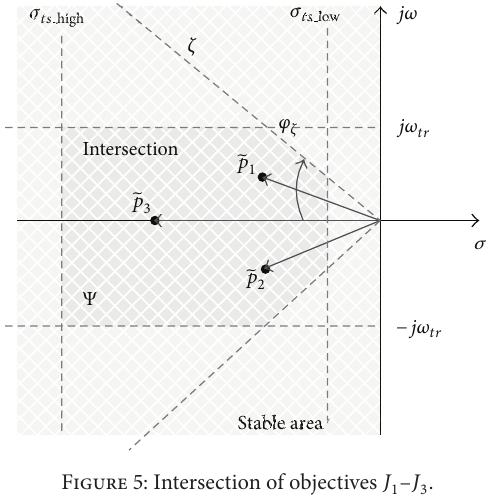
Figure 5: Intersection of objectives 𝐽 1 – 𝐽 3 .